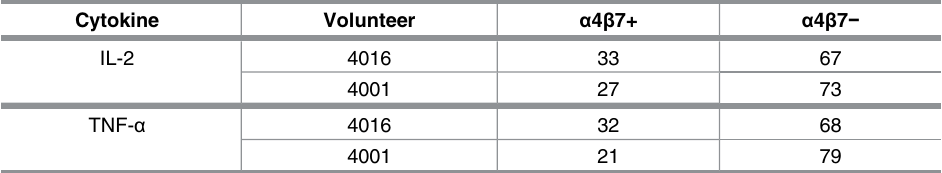
Table 2. Percentage of Total CD4+ CFA/I-specific effector responses on day 3 post-challenge attribut- able to T M and pT fh subsets in Resistant volunteers. Total pT fh represented17.0% and 8.6% of total CD4+ T cells in volunteers 4016and 4001,